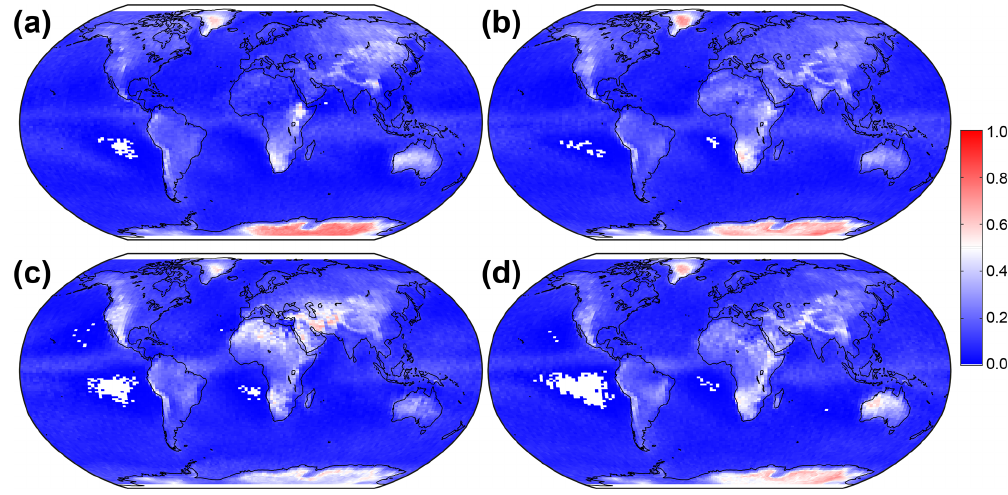
Figure 6. Same as Fig. 4a but for the 3-month periods (a) DJF, (b) MAM, (c) JJA, and (d)